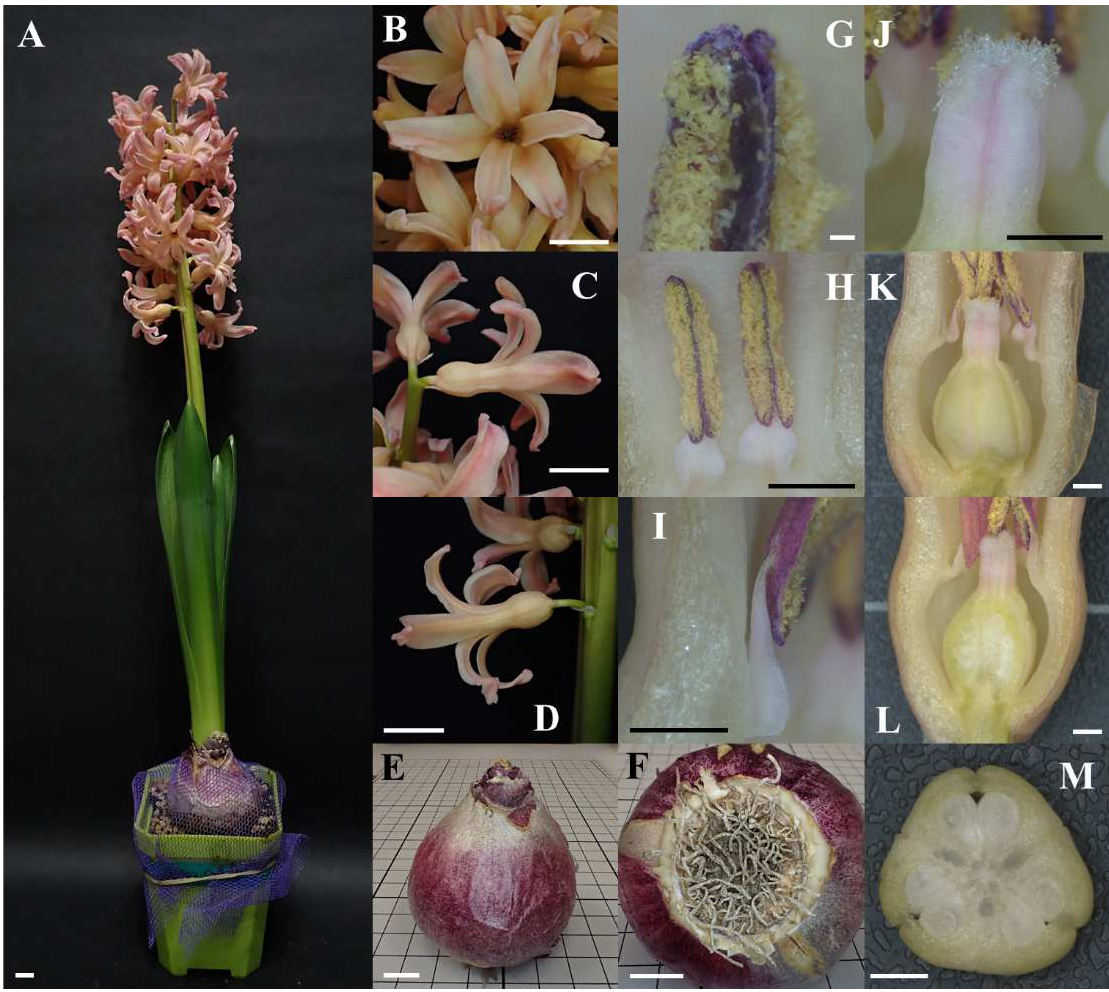
Figure 1. Overview and close-up photos of Hyacinthus orientalis L. ‘Gipsy Queen’. ( A ) Overview of an individual of Hyacinthus orientalis L. ‘Gipsy Queen’ (scale bar = 1 cm). ( B – D ) The corolla (scale bar = 1 cm). ( B ) Front view. ( C ) Side view of corolla on the upper inflorescence. ( D ) Side view of corolla on the lower inflorescence. ( E , F ) The bulb (scale bar = 1 cm). ( E ) Side view of the bulb of which tunic is in slivery purple. ( F ) The disc with remnant roots. ( G – I ) Androecium. ( G ) Pollen sacs under microscopy (scale bar = 0.01 cm). ( H ) Stamens (scale bar = 0.1 cm). ( I ) Filaments of dorsifixed anthers (scale bar = 0.1 cm). ( J – M ) Gynoecium (scale bar = 0.1 cm). ( J ) Receptive papilla on the stigma. ( K ) Superior ovary. ( L ) Longitudinal section of the ovary showing axile placentation. ( M ) Cross section of the ovary showing ovules in three locules.